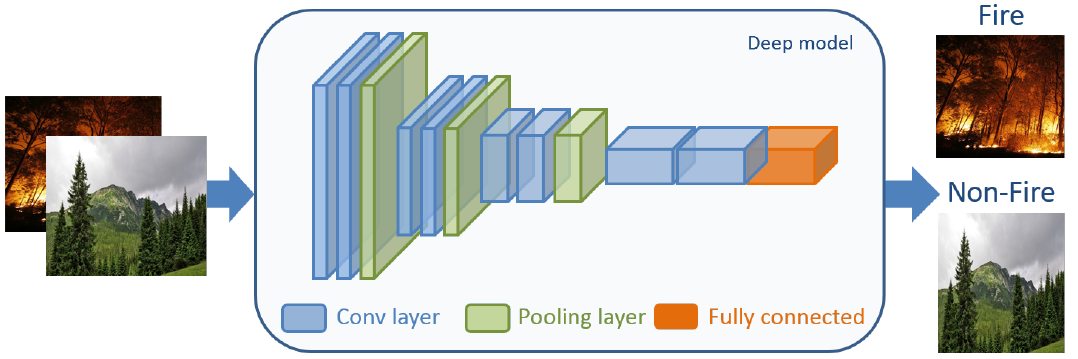
Figure 1. Wildland fire classification based on